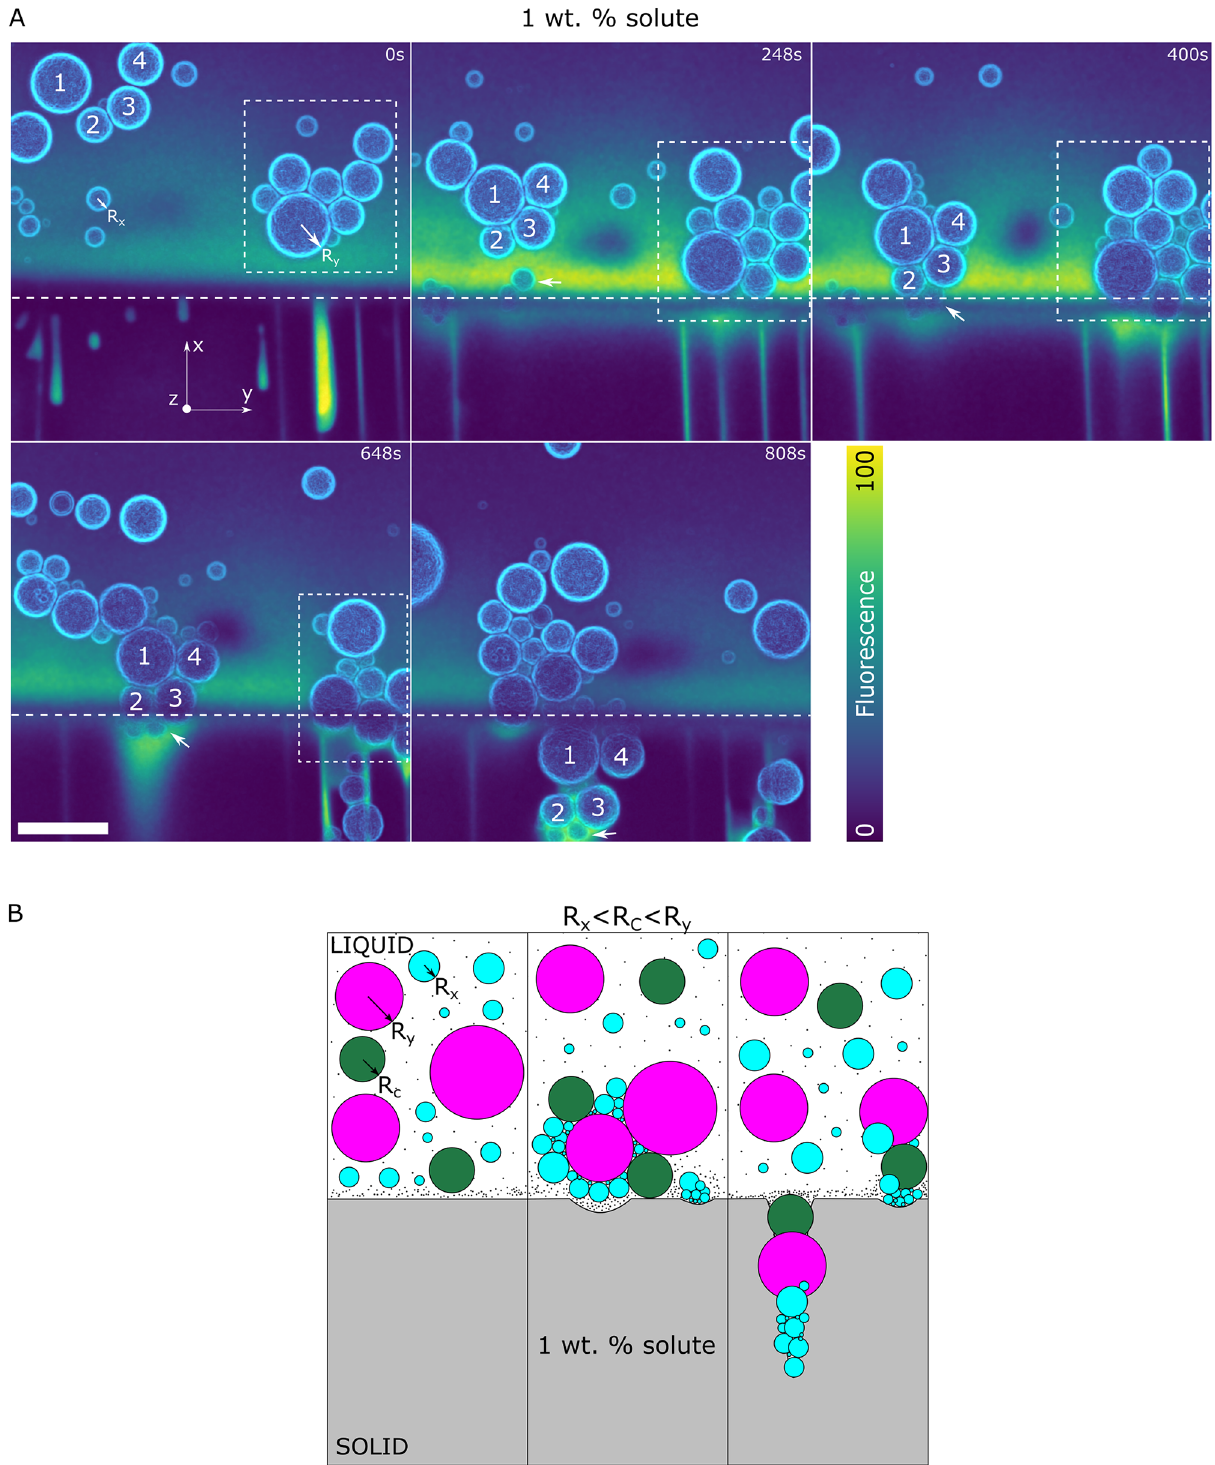
Figure 9. Interaction of polydisperse oil-in-water emulsion with an advancing ice-water front at 1 wt.% bulk solute concentration. ( A ) Droplets 1,2,3,4 form a cluster at the ice-water front, while the droplets in the insets form a cluster ahead of the front. The agglomerates depict a pushing-engulfment transition with local destabilisation of the ice-water front ( B ) Schematic depicting the experimental observations in ( A ), where small droplets ( R x < R c ) form a barrier and subsequently form close-packed agglomerates with a combination of droplet sizes ( R x < R c < R y ) before getting captured in the solid. Oil is in cyan, water in colormap viridis (fluorescence bar) while ice is in black. Scale bar = 100 µ m . © (2020) Tyagi et al. (10.6084/m9.figshare.13176221) CC BY 4.0 license https ://creat iveco mmons .org/licen